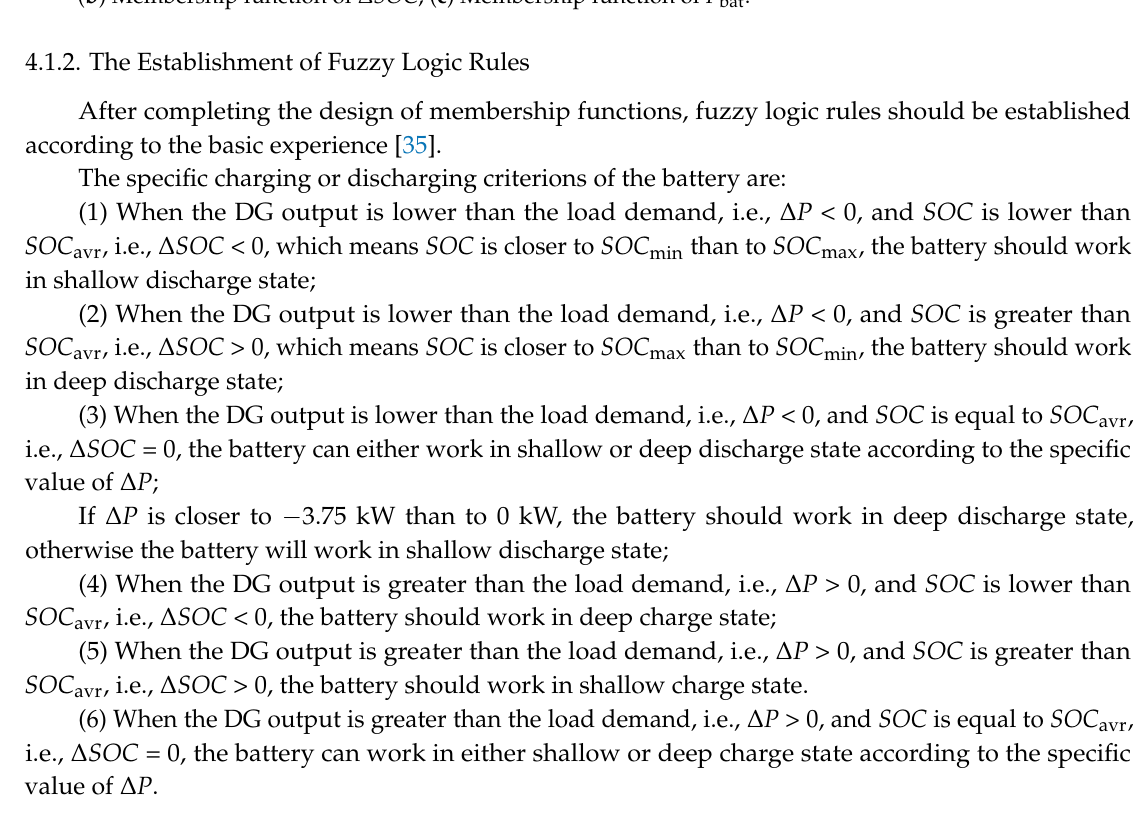
Figure 7. Membership functions of the input and output: ( a ) Membership function of Δ P ; ( b ) Figure Membership function of Δ SOC ; ( c ) Membership function of P bat .